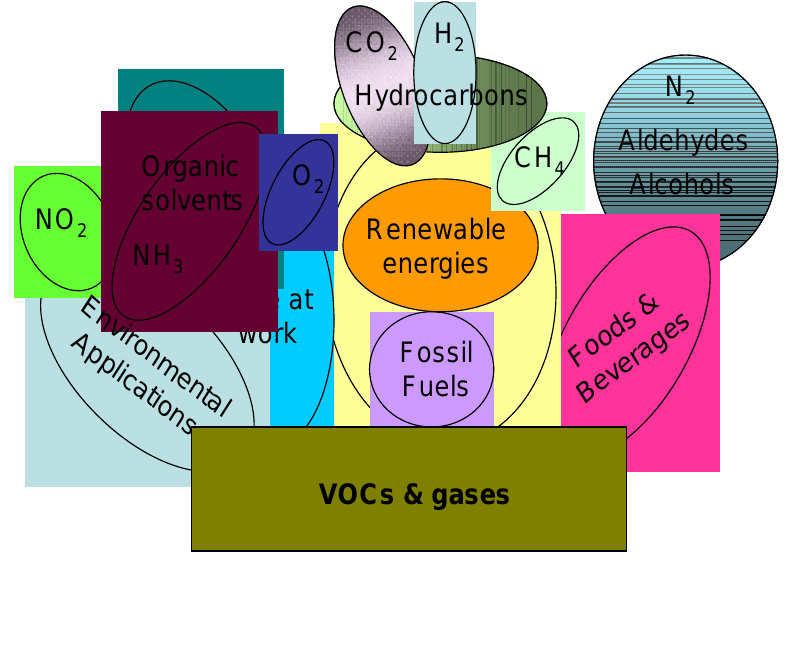
Figure 1. Principal fields where VOC sensors have many applications, and species usually measured.